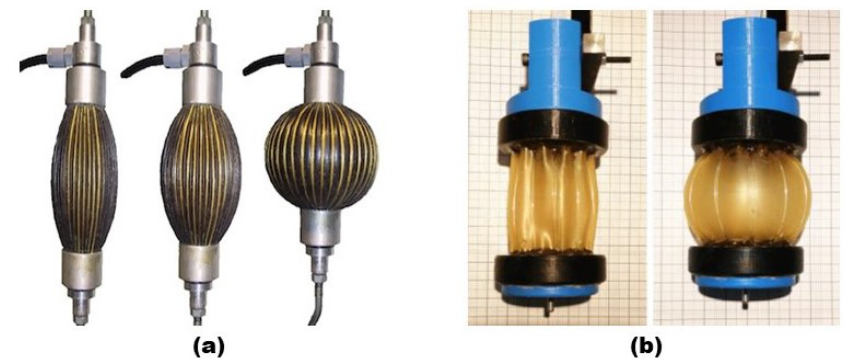
Figure 5. ( a ) Pleated PAM [32,33]. ( b ) Modified Pleated PAM [34].